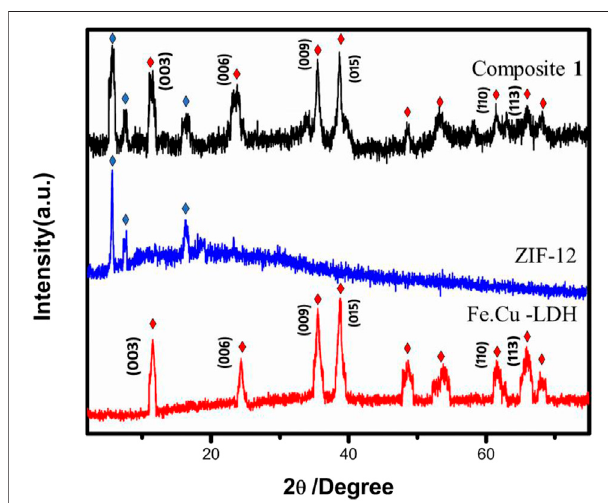
FIGURE 1 | PXRD patterns of LDH, ZIF-12, and composite 1